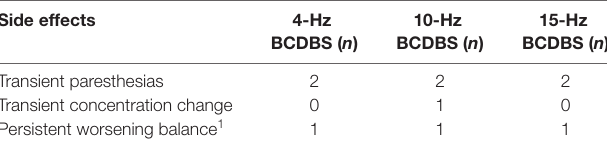
TABLE 1 | Stimulation induced side effects during burst-cycling deep brain stimulation (BCDBS).